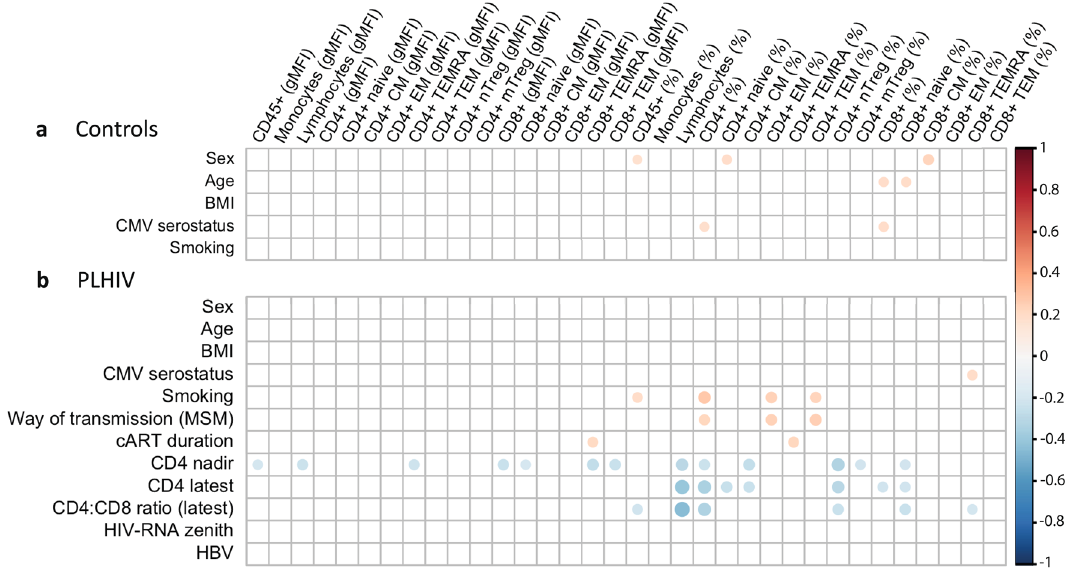
Figure 4. Spearman’s rank correlation plots of host factors with CCR5 expression (MFI and %) of immune cell subsets in ( a ) controls and ( b ) PLHIV. The size of the circles and the depth of the colour represent the strength of the correlation, while the direction is indicated by colours: red for a positive correlation and blue for a negative correlation. A blank square represents the absence of a significant correlation, while a coloured square represents a significant correlation (FDR-corrected p value < 0.05).